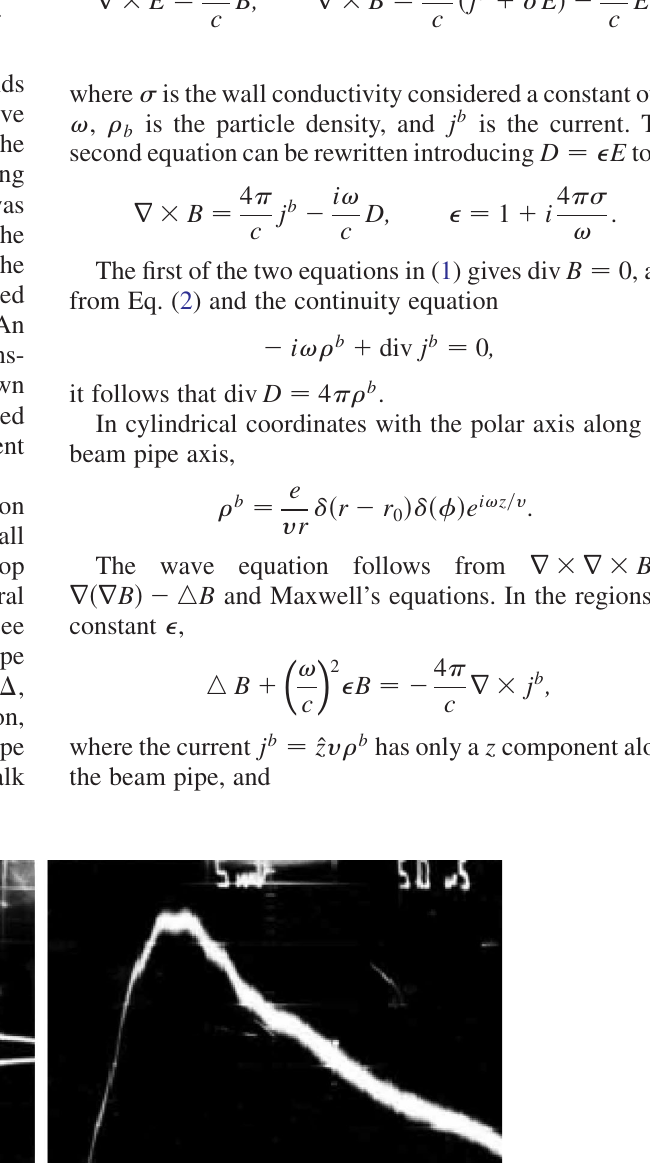
FIG. 2. Field outside of the Al 0.5 mm round beam